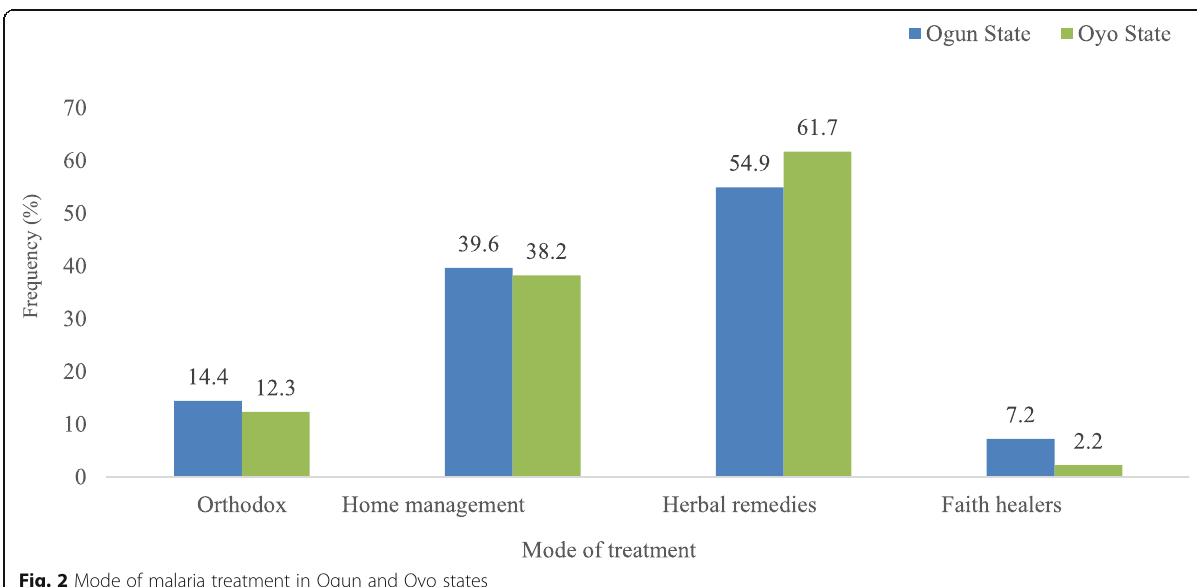
Fig. 2 Mode of malaria treatment in Ogun and Oyo